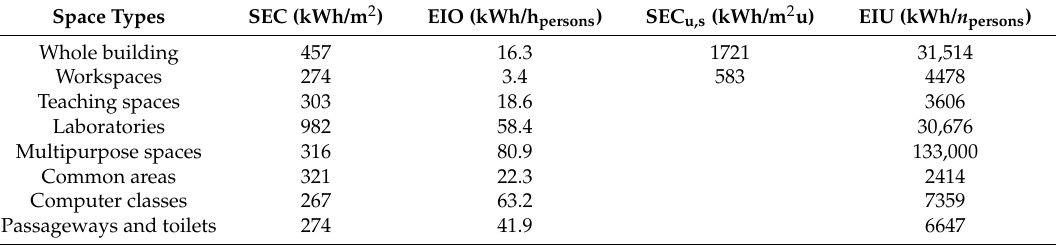
Table 6. Values of energy efficiency indicators for the various spaces after the renovation.